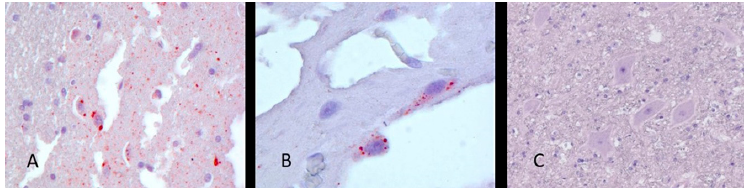
Figure 1. Immunohistochemical (IHC) staining for RABV antigen in fixed brain tissue from the Dominican Republic (DOM) patient (A18-2173). ( A ) RABV antigen detection at 400× magnification. ( B ) Neuronal cytoplasmic inclusions at 630× magnification. ( C ) Negative control brain at 400× magnification. Streptavidin–biotin complex staining method using rabbit antibodies against RABV